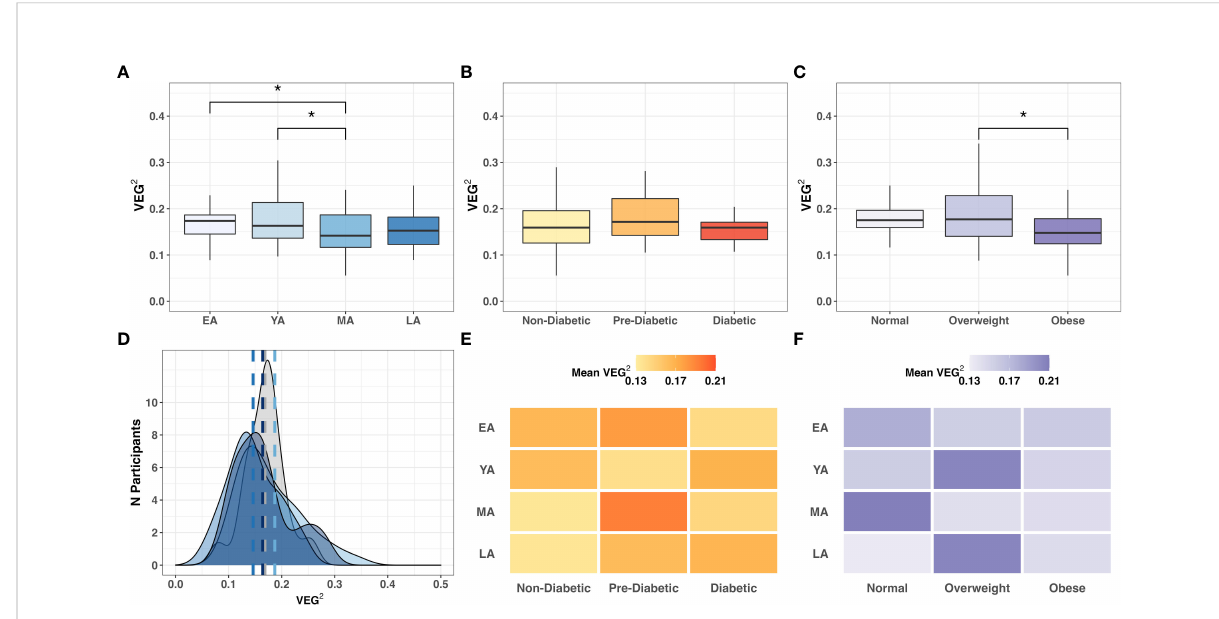
FIGURE 8 Intergroup comparison of VEG 2 across (A) age groups (P=0.064 ); (B) T2DM categories ( P=0.396 ); and (C) BMI categories ( P=0.005) . Frequency distribution of participants by age groups among binned VEG 2 scores is summarized by a color-coded density plot fi tted over a histogram (D) Heatmaps indicating the range of VEG 2 scores distributed across age groups and (E) T2DM categories or (F) BMI categories. Statistical signi fi cance denoted: * ( P